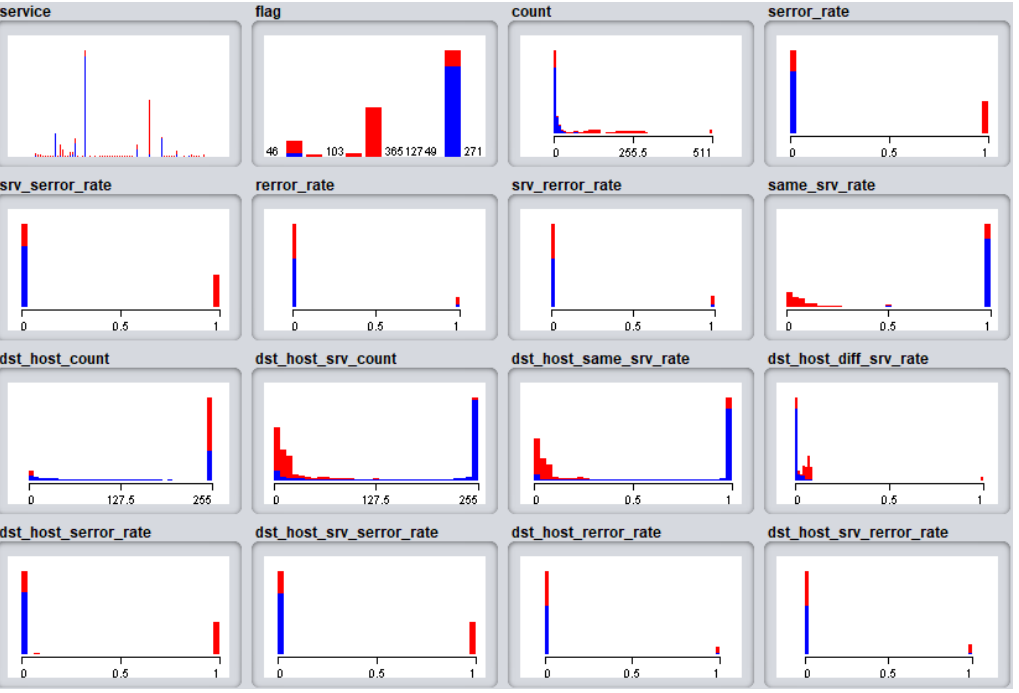
Figure 7. Analysis between features. Table 5. flag(f4)